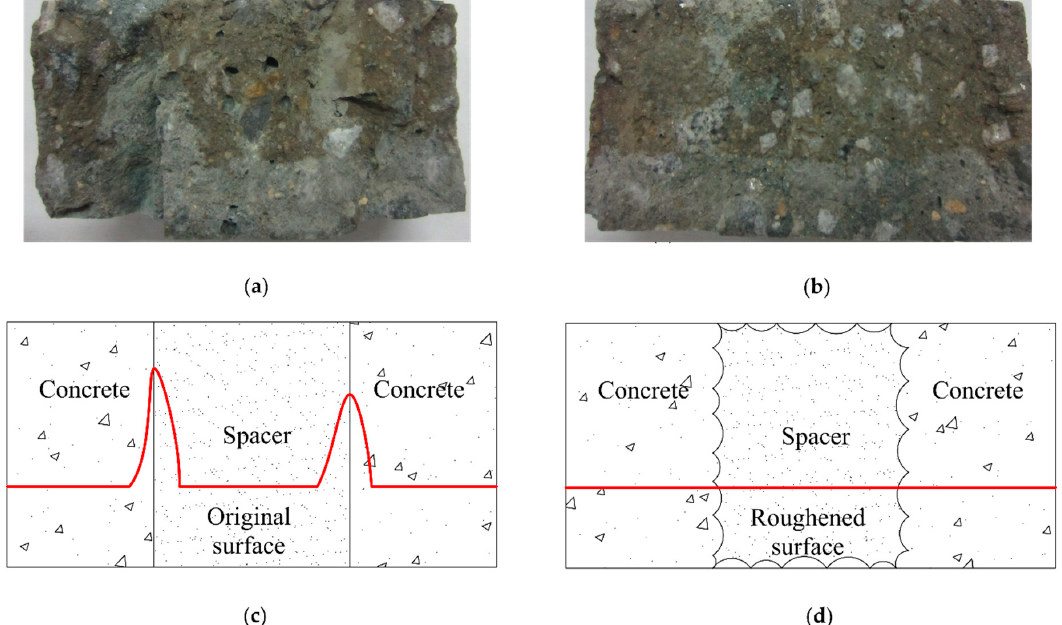
Figure 7. Chloride ion penetration depths of SS: ( a ) a picture of the split surface of the specimen without surface treatment where a significant defect at the spacer–concrete interface occurs; ( b ) a picture of the split surface of the specimen with surface treatment; ( c ) a schematic plot of the split surface of the specimen without surface treatment where a significant defect at the spacer–concrete interface occurs; and ( d ) a schematic plot of the split surface of the specimen with surface